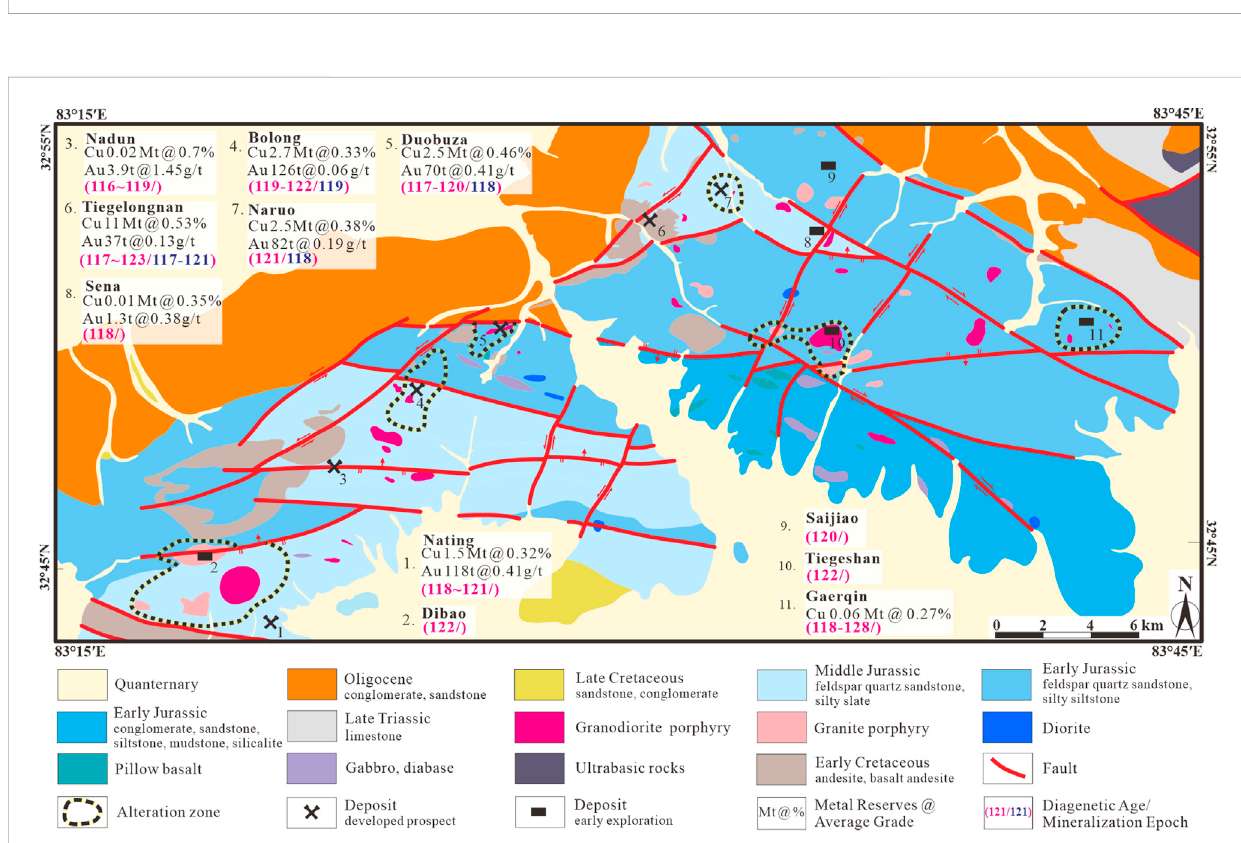
FIGURE 5 Geology and location of porphyry Cu and Au deposits in Duolong District (modi fi ed from Lin et al., 2017).